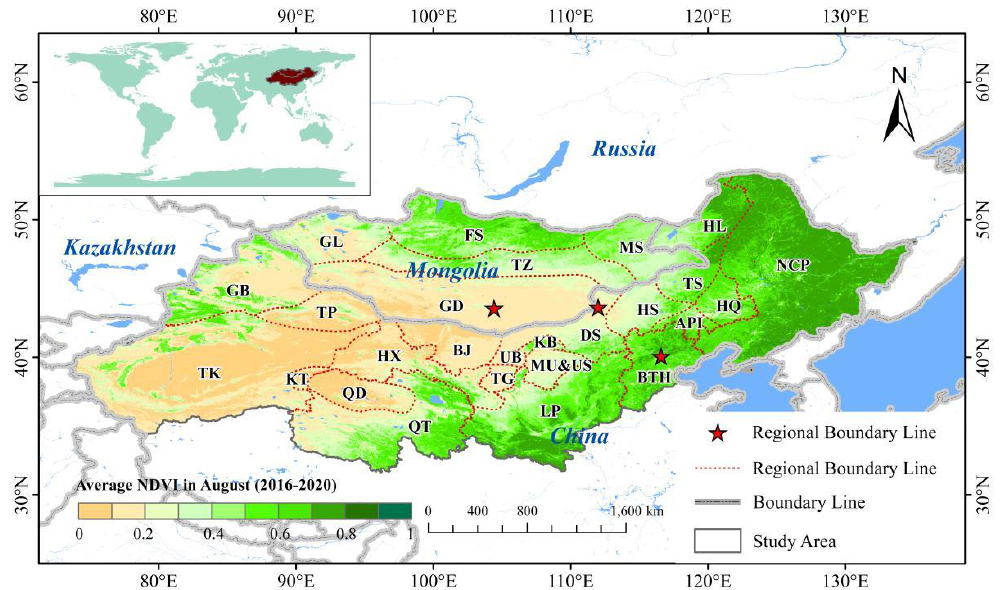
Figure 1. Map of the study area (including 27 sub-regions). The background is the average NDVI in August during 2016 – 2020. GL: Mongolian Great Lakes Region, FS: Mongolian Forest Steppe, TZ: Mongolian Transition Zone from Gobi to Steppe, MS: Mongolian Steppe, GD: Mongolian Gobi De- sert, GB: Gurbantunggut Desert, TP: Turpan Basin, TK: Taklimakan Desert, KT: Kumtag Desert, HX: